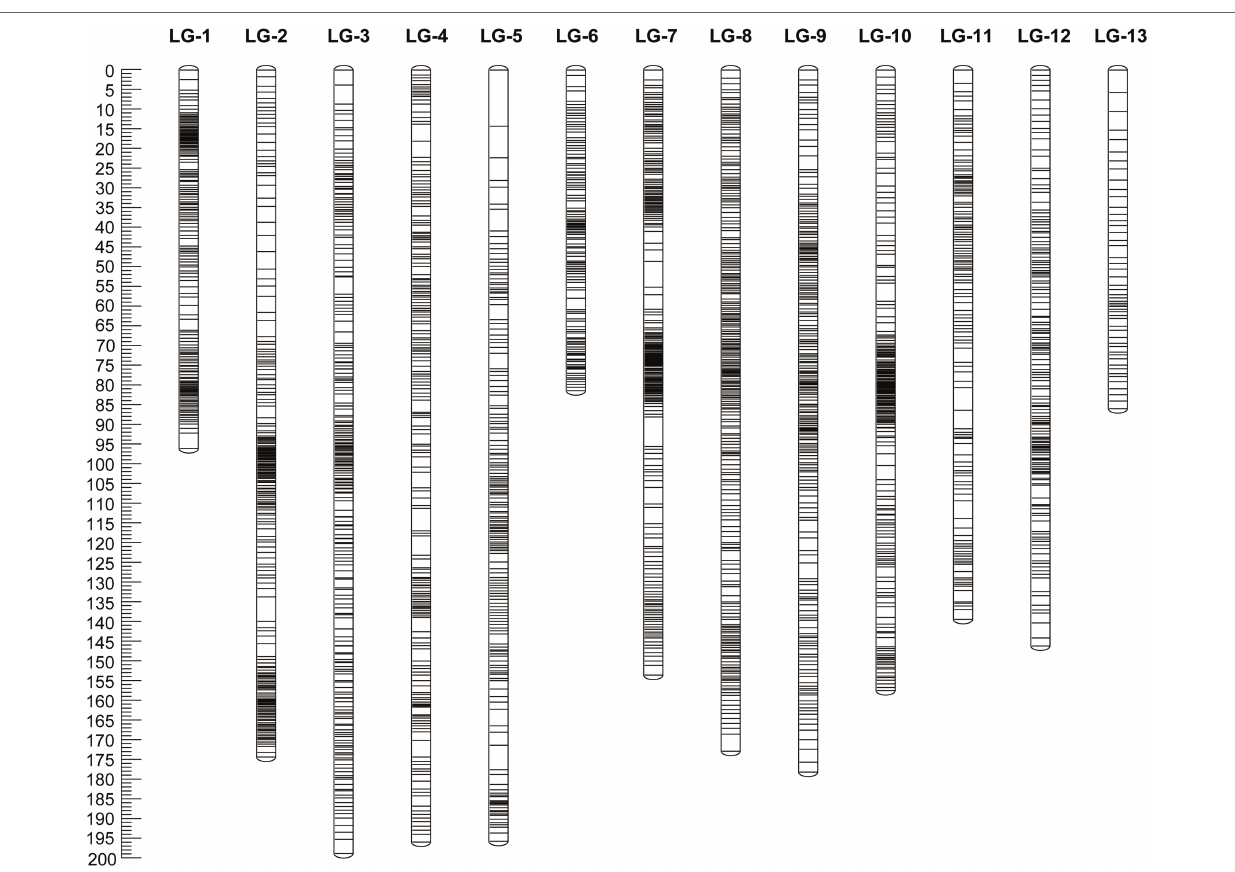
FIGURE 1 | Genetic map constructed in the S 1 mapping population derived from self-pollination of “Namikata 73.” The map includes 2,365 markers (29 SSR, 93 EST-SNP, and 2,243 GBS-SNP) across 13 LGs for a total length of 1,968.4 cM.